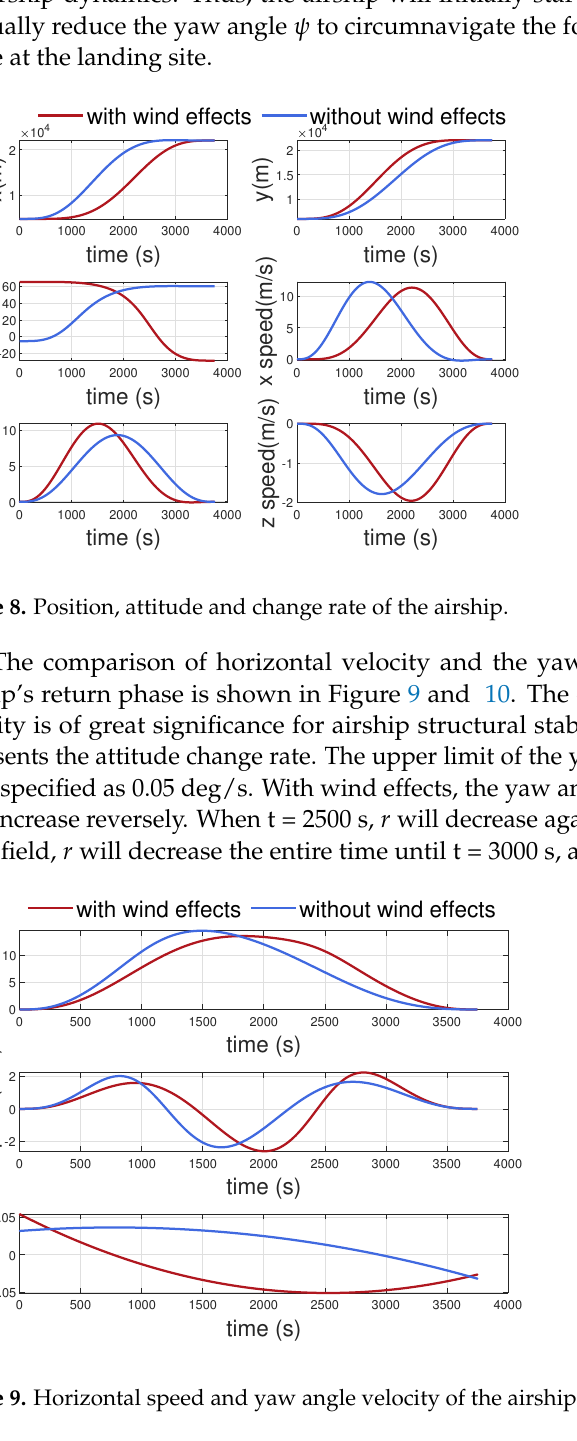
Figure 9. Horizontal speed and yaw angle velocity of the